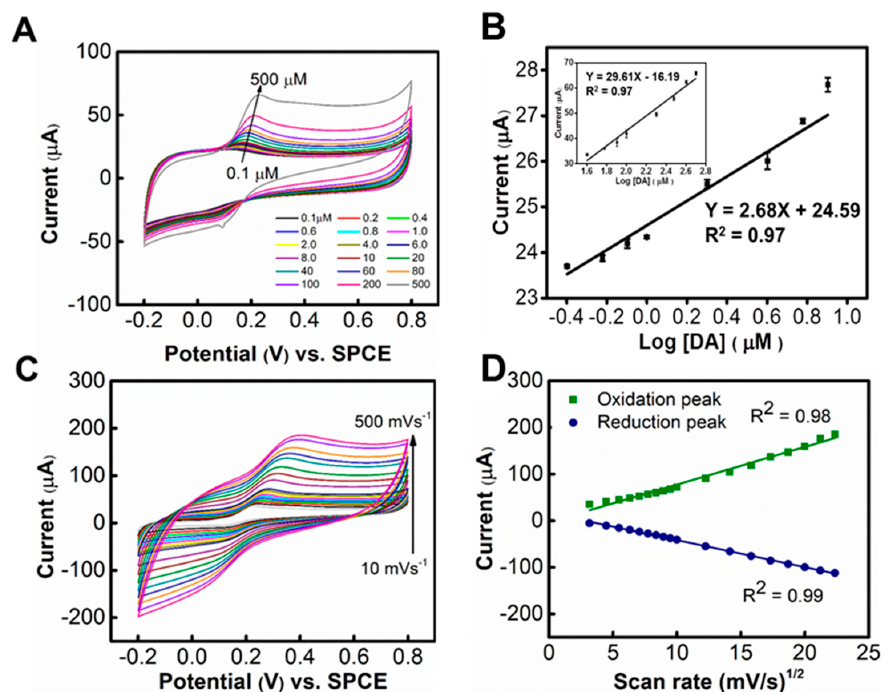
Figure 3. ( A ) CV curves of tyrosinase/chitosan/rGO/SPCE in the presence of various concentrations of DA (0.1 ‒ 500 μ M). ( B ) Calibration curve between logarithmic value of DA concentration and oxidation peak currents of the tyrosinase/chitosan/rGO/SPCE. Error bars represent the standard deviation from triplicate measurements. ( C ) CV of tyrosinase /chitosan/rGO/SPCE at 500 μ M of DA with various scan rates (10 ‒ 500 mVs -1 ). ( D ) Calibration curve between square root of scanning rate and oxidation/reduction peak currents.